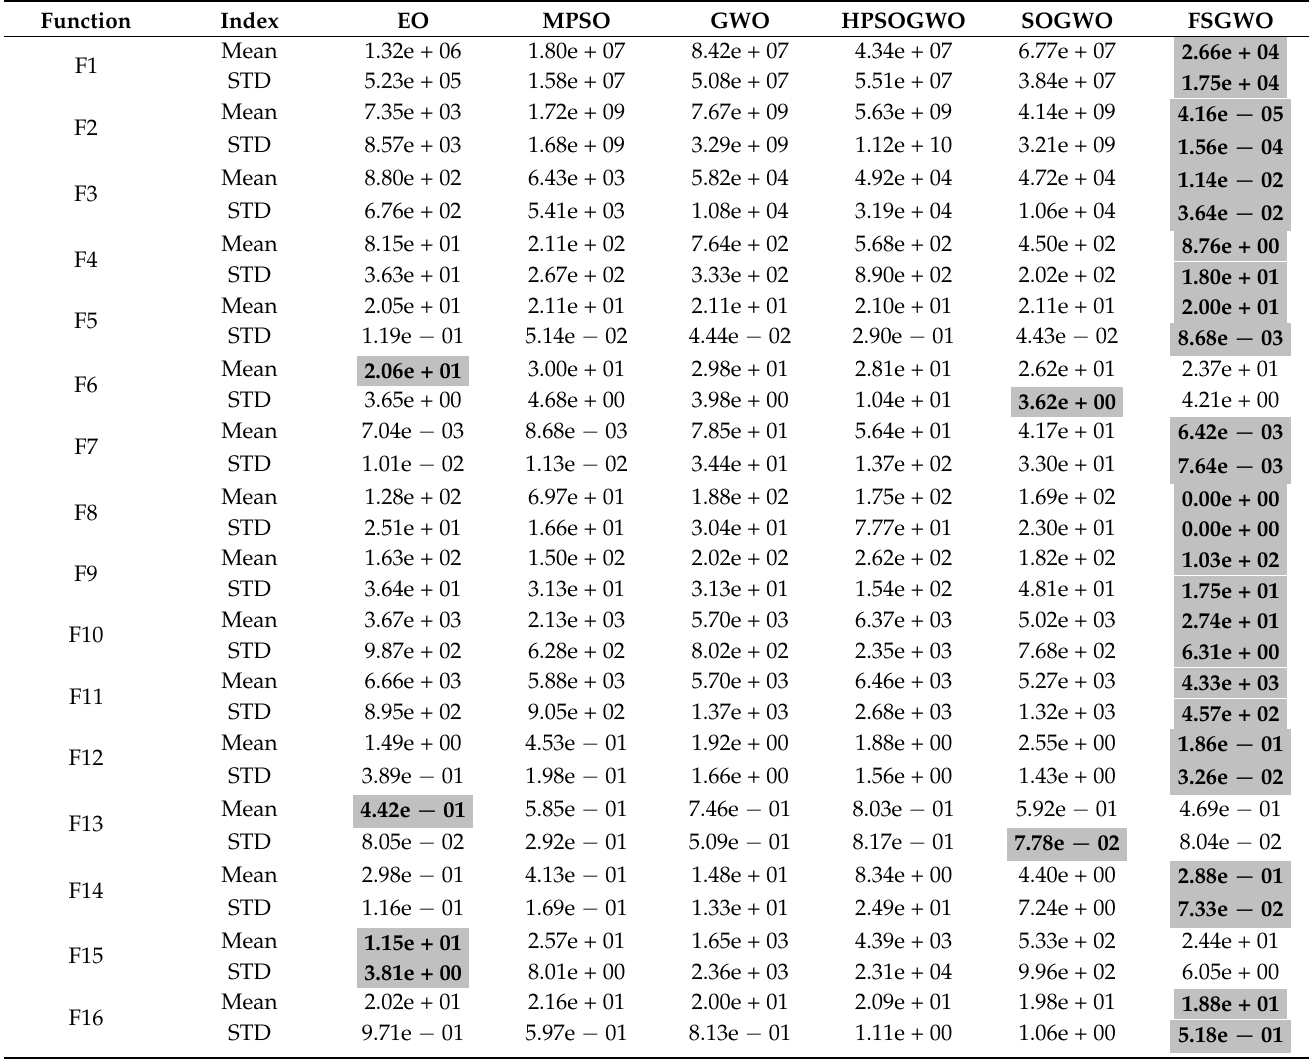
Table 5. Results of the related algorithms for 50-dimensional